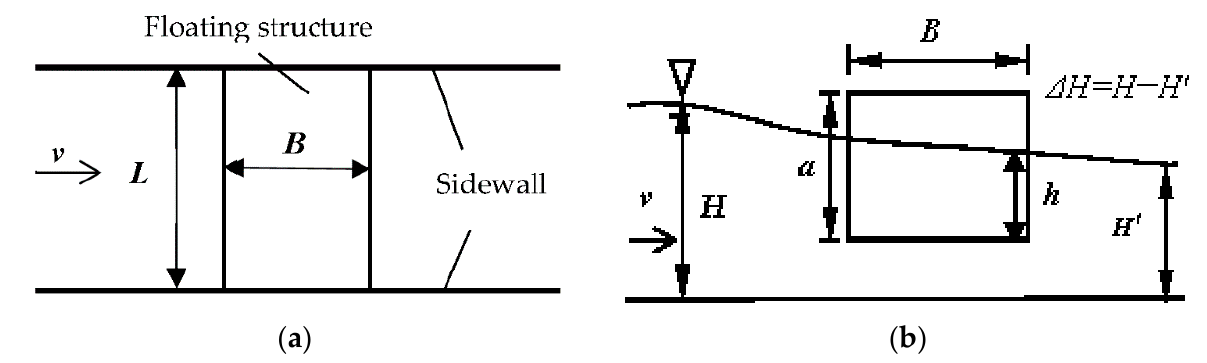
Figure 3. Main parameters of the floating structure: ( a ) Plan view, ( b ) Front view. The downstream water depth H (cid:48) ([L]) in the geometric dimension, gravitational constant of acceleration g [L/T 2 ] in the kinematic dimension, and water density ρ in the dynamic dimension ([ML − 3 ]) are selected as the three basic physical quantities. According to the π theorem: M F where the dimensionless factor on the left side is defined as M f . We define π 2/ π 3 = B/a as the aspect ratio of the floating structure; h/H (cid:48) is the relative draft; ∆ H/H (cid:48) is the relative (cid:112) gH is the Froude number of the upstream section. water level difference, and π 6 = Fr = v / The length of the section is five times the water depth of the flume at the upstream end of the floating structure, where the flow is stable and is not affected by the structure. The simplified result is: